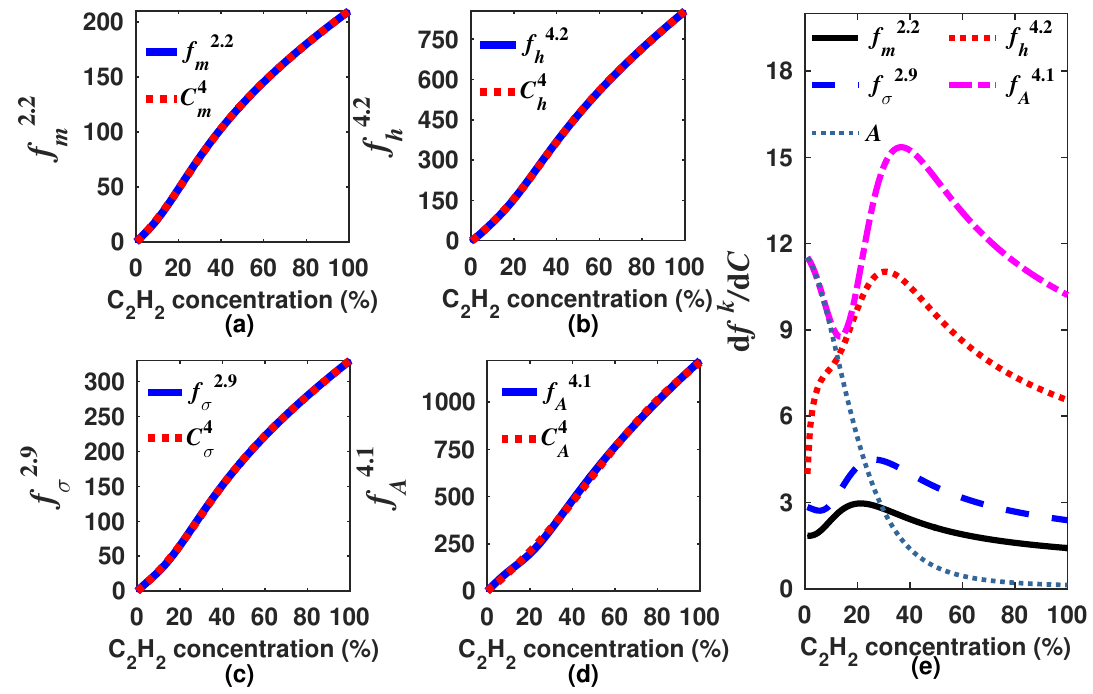
Figure 9. Simulated optimal generating functions ( a ) f 2.2 m ; ( b ) f 4.2 corresponding polynomial fits; ( e ) C 2 H 2 sensitivities of each one of the optimal generating functions and of that obtained when only the peak amplitude of D M is